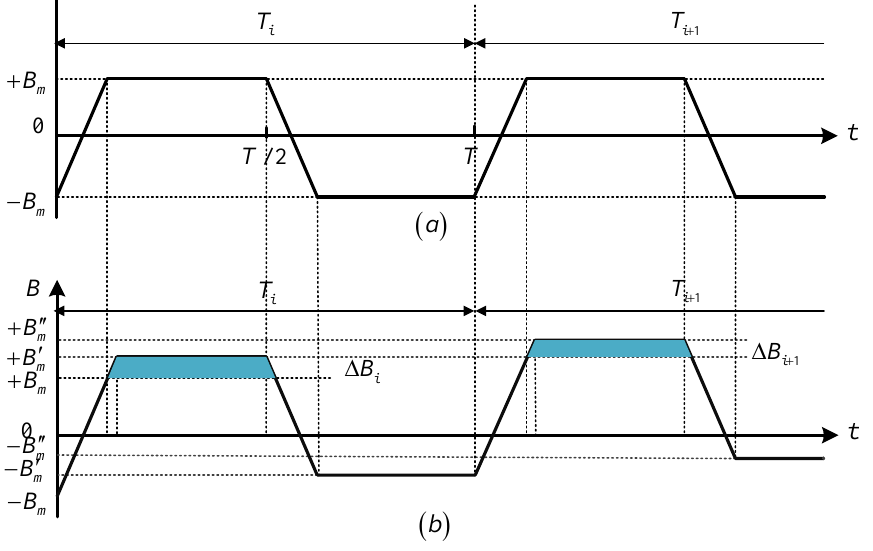
Figure 4. The B − t curves: ( a ) ∆ ¯ v i = 0, ∆ B i = 0. ( b ) ∆ ¯ v i > 0, ∆ B i >